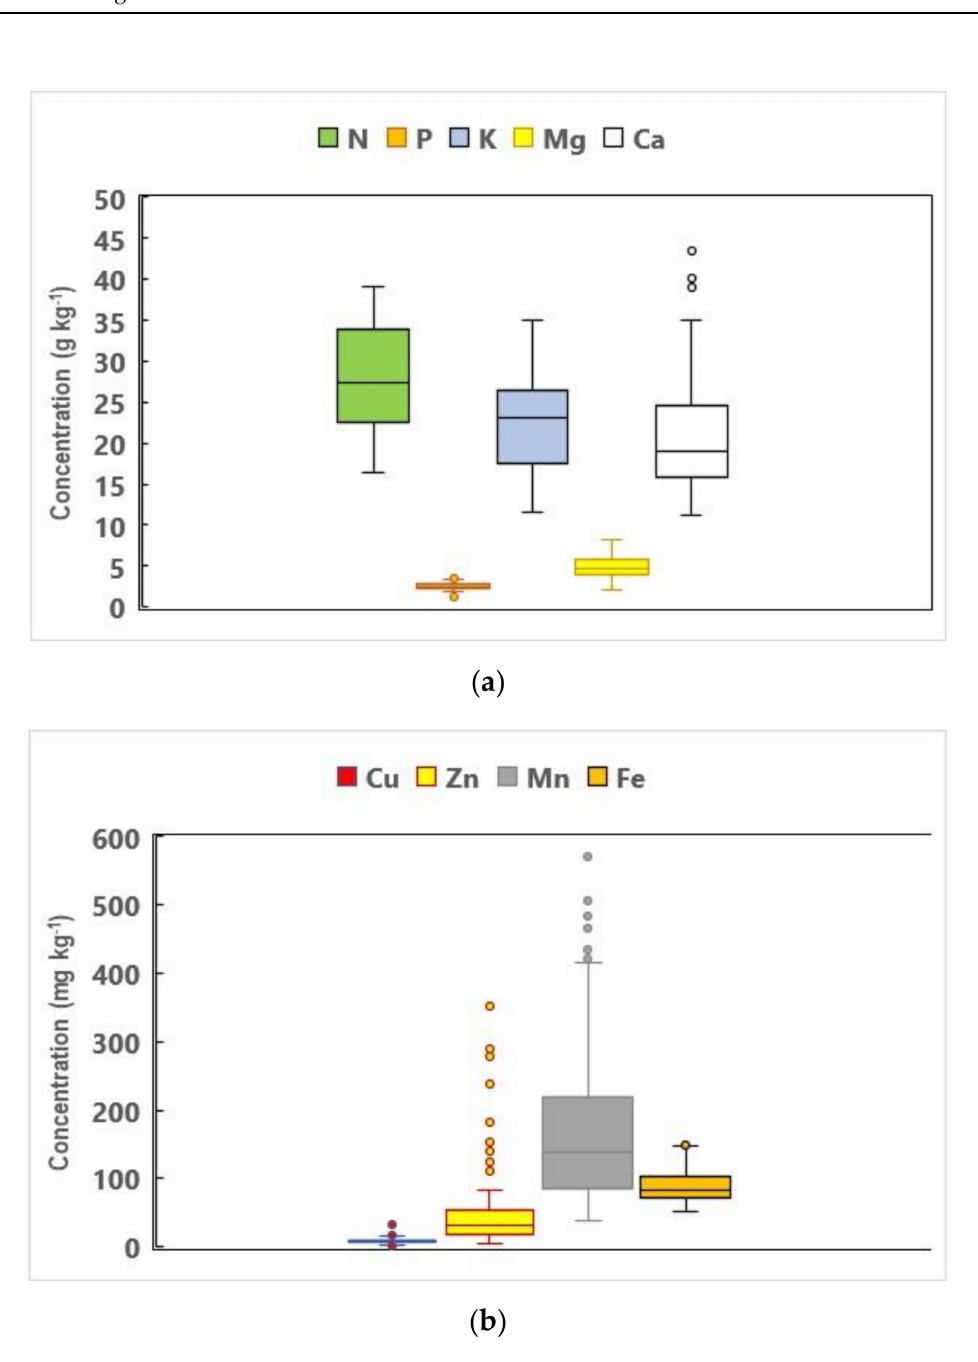
Figure 1. Boxplots of foliar concentrations of (a) macronutrient and (b) micronutrient subcompositions of true negative specimens peach orchards in Rio Grande do Sul,